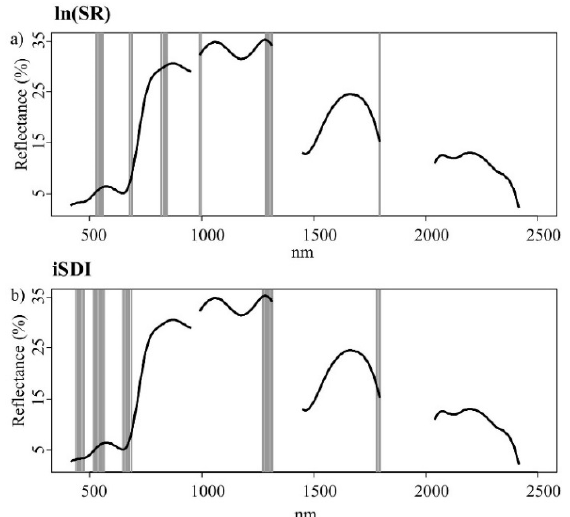
Figure 5. Important wavebands (grey bars) selected with the help of an iterative variable deletion procedure, for estimating ( a ) the species richness (ln(SR)) and ( b ) the inverse Simpson’s diversity index (iSDI) in grassland plots using the calibration subset ( n = 51). The black line represents the mean spectral reflectance curve for grassland plots in the whole data set ( n = 102).